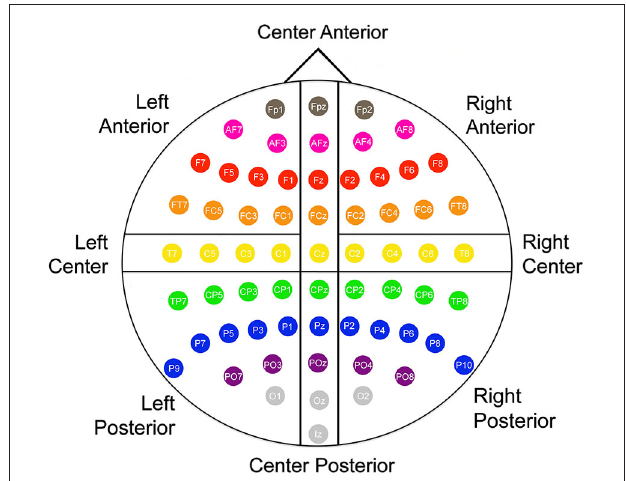
FIGURE 1 | Montage and scalp region designations used in all analyses